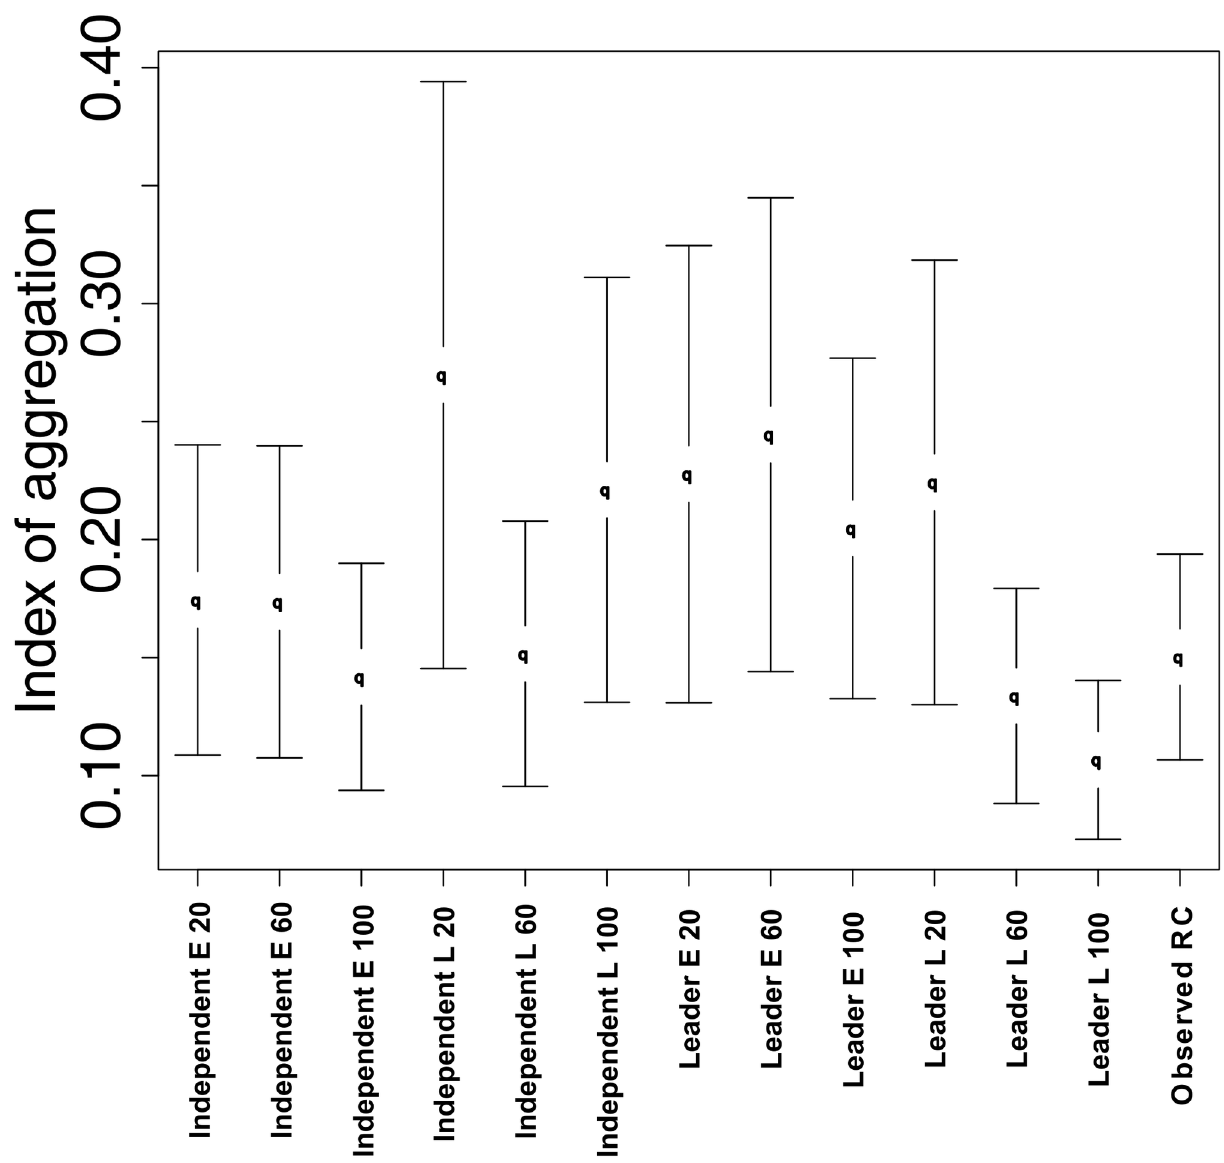
Figure 3. Index of aggregation for the observed and simulated red colobus groups. Error bars on the graph represent 95% confidence